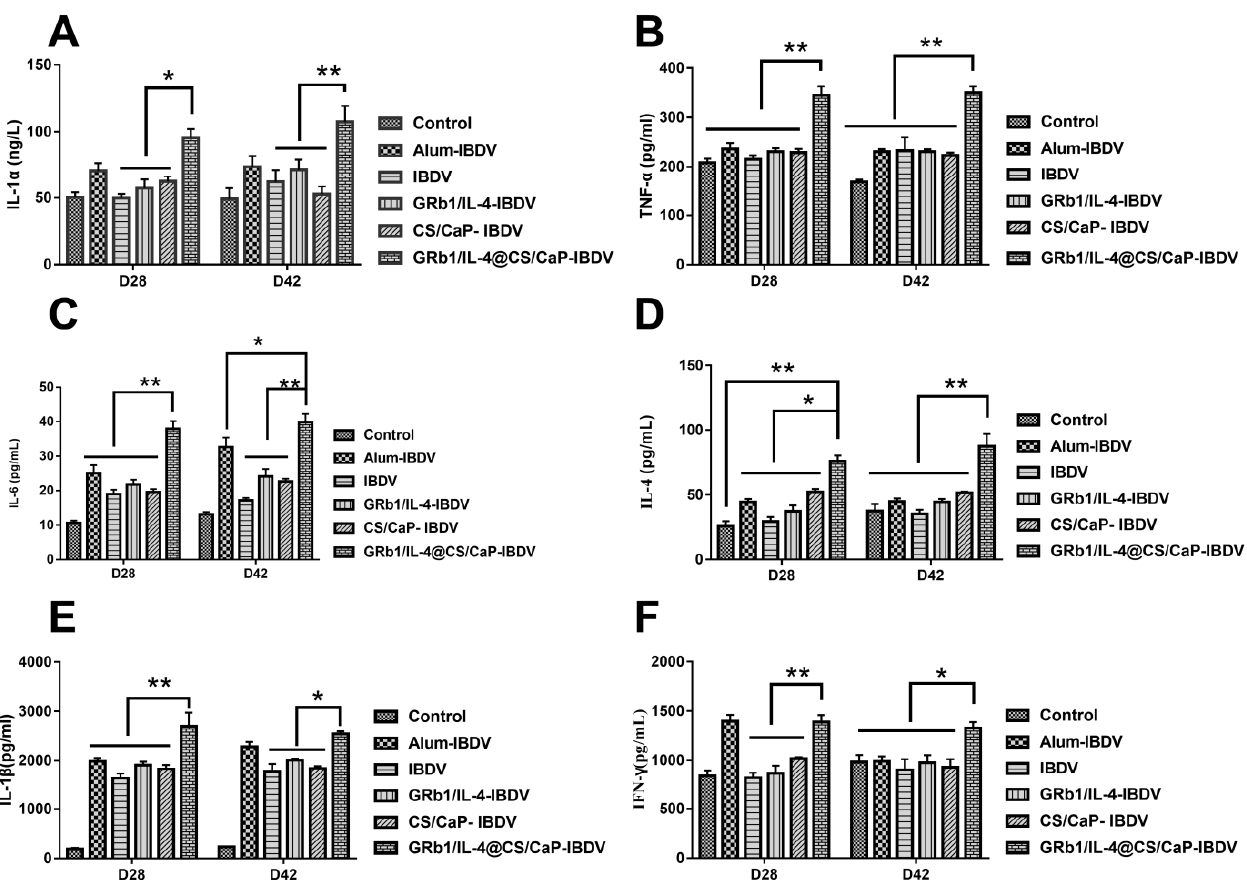
Figure 6. The chicken sera were harvested separately 28 d and 42 d following the final vaccination after sacrifice. The seral cytokine levels were determined. ( A ) IL-1 α , ( B ) TNF- α , ( C ) IL-6, ( D ) IL-4, ( E ) IL-1 β , ( F ) IFN- γ . Data represented are means ± SEMs (* p < 0.05, ** p < 0.01).